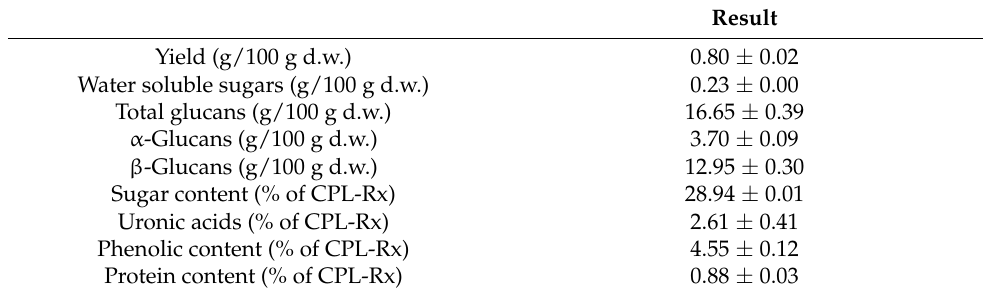
Table 1. Yield and chemical composition of crude polysaccharide obtained from R. rugosa root; results given in g/100 g of dry weight (d.w.) or in % of crude polysaccharide. Values are presented as mean ± standard deviation ( n ≥ 3).